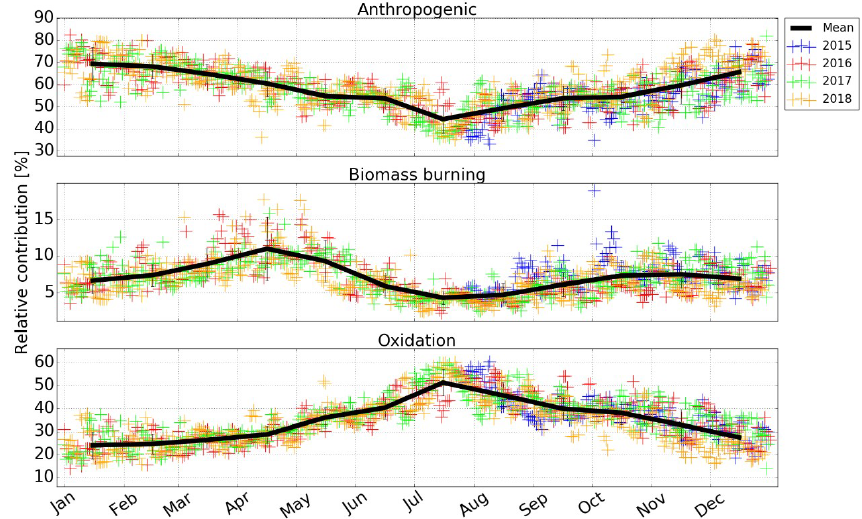
Figure 9. Seasonality of the relative contribution (%) of the anthropogenic, biomass burning, and oxidation tracers in the GEOS-Chem simulation to the total CO tropospheric columns at Hefei (32 ◦ N).